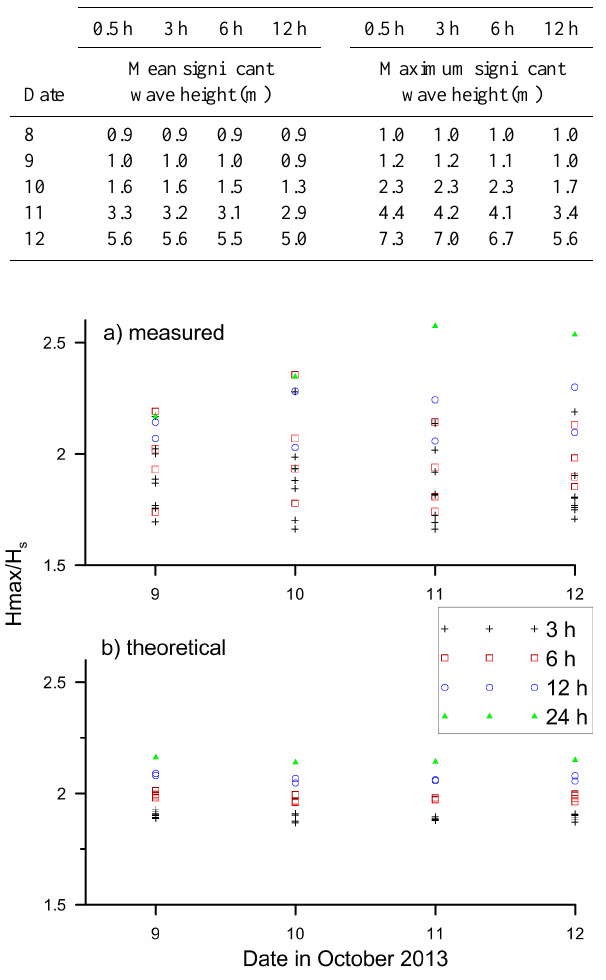
Figure 7. Ratio of maximum wave height to significant wave height (a) based on measured data and (b) estimated using the Rayleigh distribution for data collected for 3, 6, 12 and 24h durations.